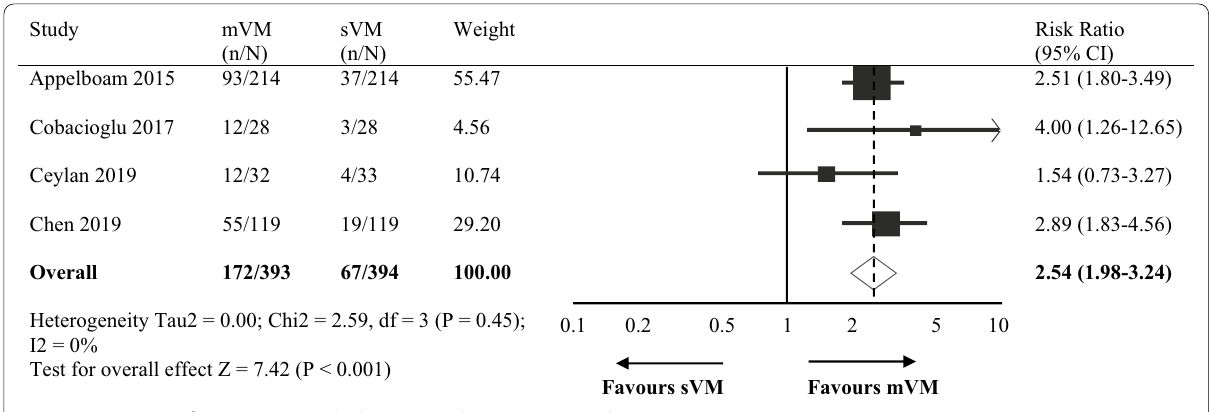
Fig. 2 Comparison of Return to Sinus Rhythm in 1 min between MVM and SVM